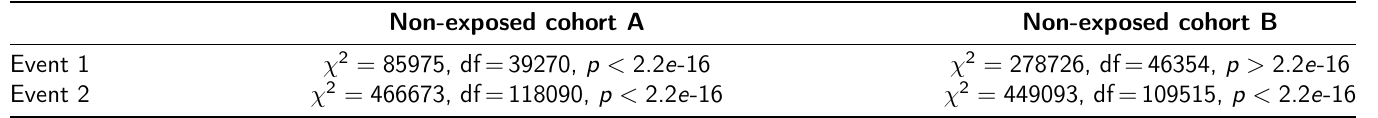
Table S1: Results of X 2 tests comparing exposed cohort to each non-exposed cohort, for each